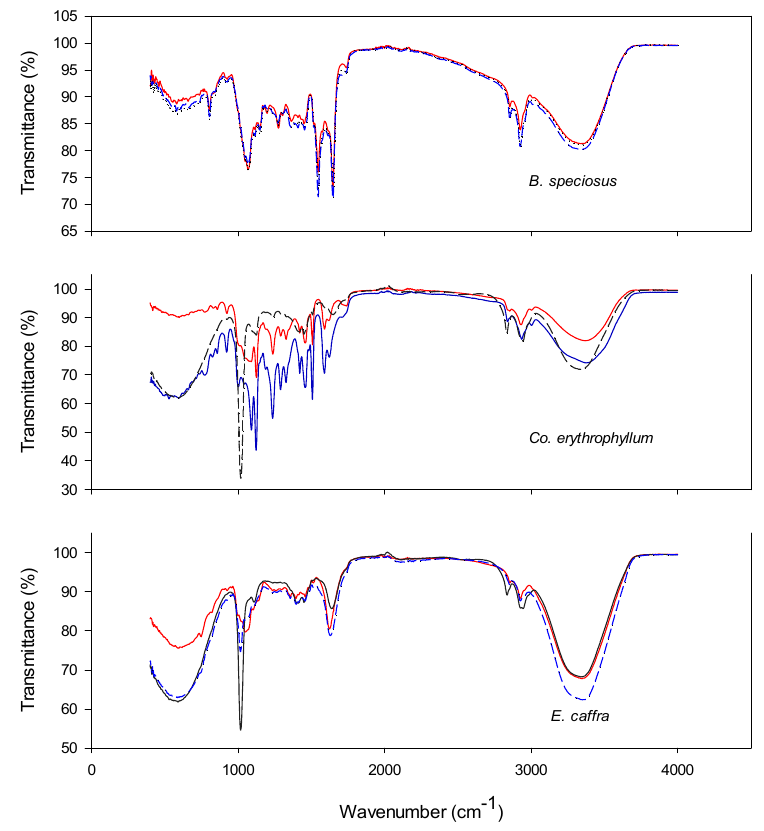
Figure 6. FTIR of Bolusanthus speciosus , Combretum erythrophyllum , and Erythrina caffra at 0 (blue), 20 (black), and 32 (red) d of controlled deterioration. Seeds were subjected to controlled deterioration at 40 ° C and 100% relative humidity. Samples were taken at intervals of 4 d and the samples were subjected to both germination and electrolyte conductivity measurements. Table 1. FTIR table including the compounds present in Pisum sativum and Cucurbita pepo at 0 (control), 20, and 32 d of controlled deterioration.